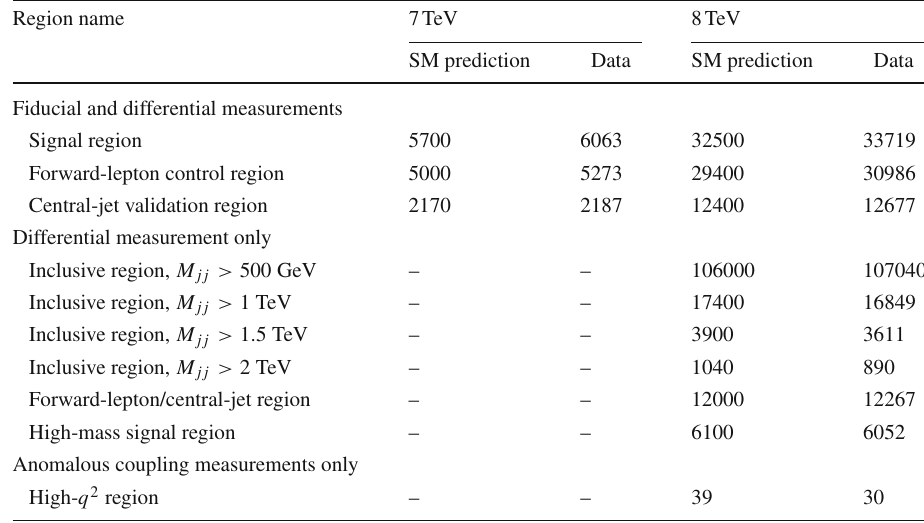
Table 4 Observed data and total predicted SM event yields in each measurement region. The MC predictions are normalized to the theoretical cross sections times branching ratios in Table 2. The relative uncertainty of the total